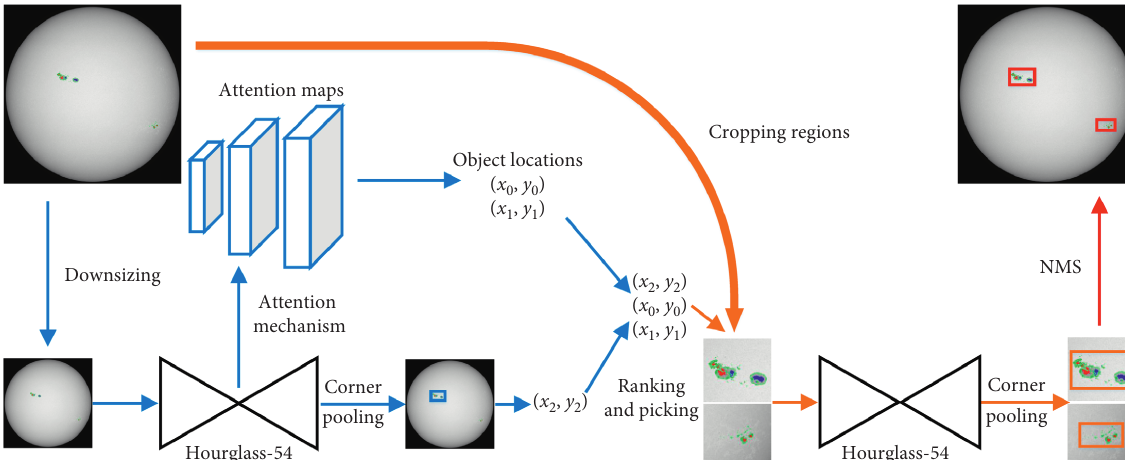
Figure 2: The main flow of the network. The first stage of generating object locations is plotted in blue, which is to find approximate locations and rough sizes of the sunspot groups on the solar full images. The second stage of detecting objects is plotted in orange, which is to further determine the specific locations of the sunspot groups on the basis of the first stage and give the classification and confidence score of the sunspot groups. The third stage of merging detection is plotted in red, which is to merge the detections for eliminating the redundant boxes.